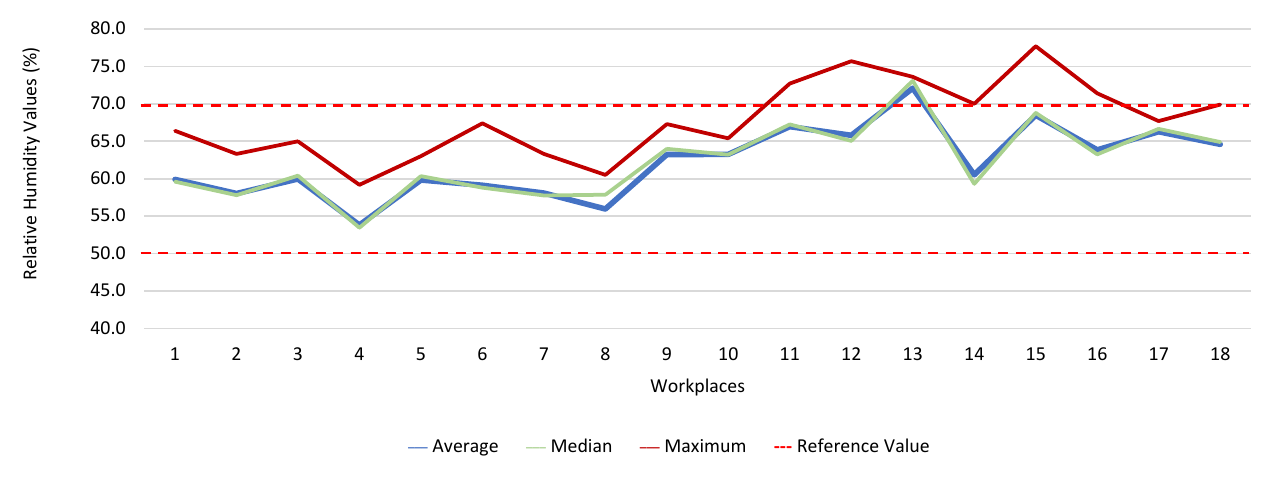
Figure 17. Temperature values (°C) inside workplaces.